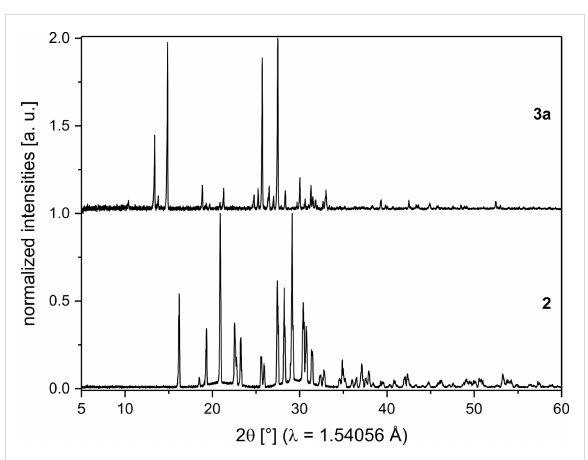
Figure 1: Comparison of XRPD pattern of malonodinitrile ( 2 ) and ( p -fluorobenzylidene) malonodinitrile ( 3a ). The patterns are baseline